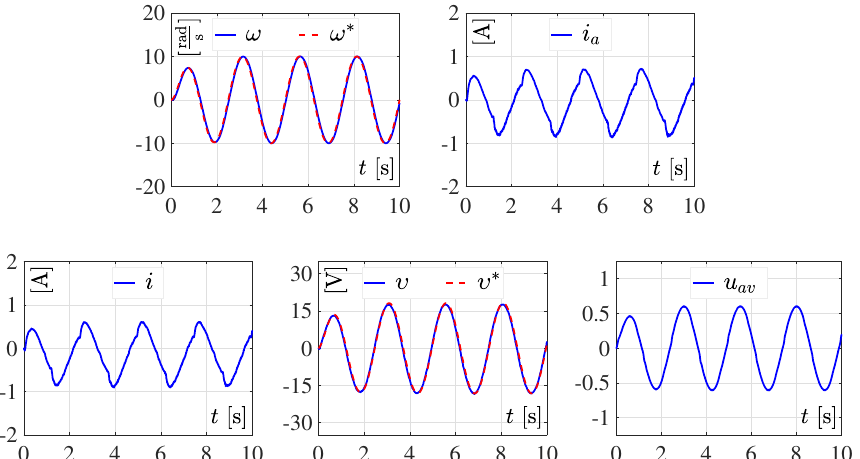
Figure 9. Experimental response of the system in closed-loop for the third desired angular velocity ω ∗ (24).